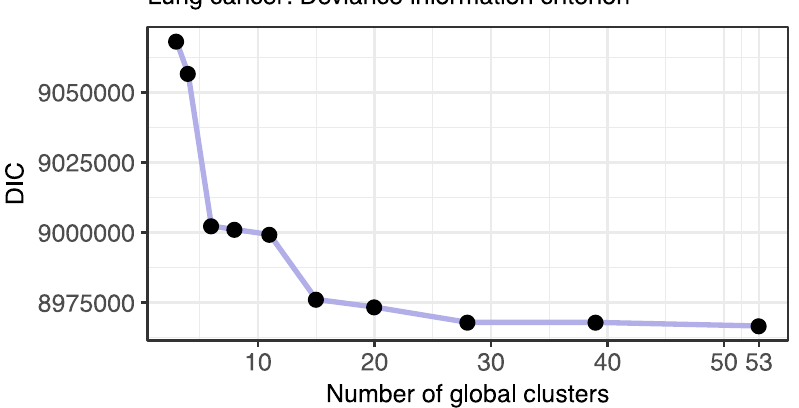
Fig 18. Devianceinformation criterion (DIC) for selecting number of clusters in the lung cancer dataset. The plot shows the DIC for a range of numbersof globalclusters when the number of local clusters is set to three. The DIC is minimizedfor 53